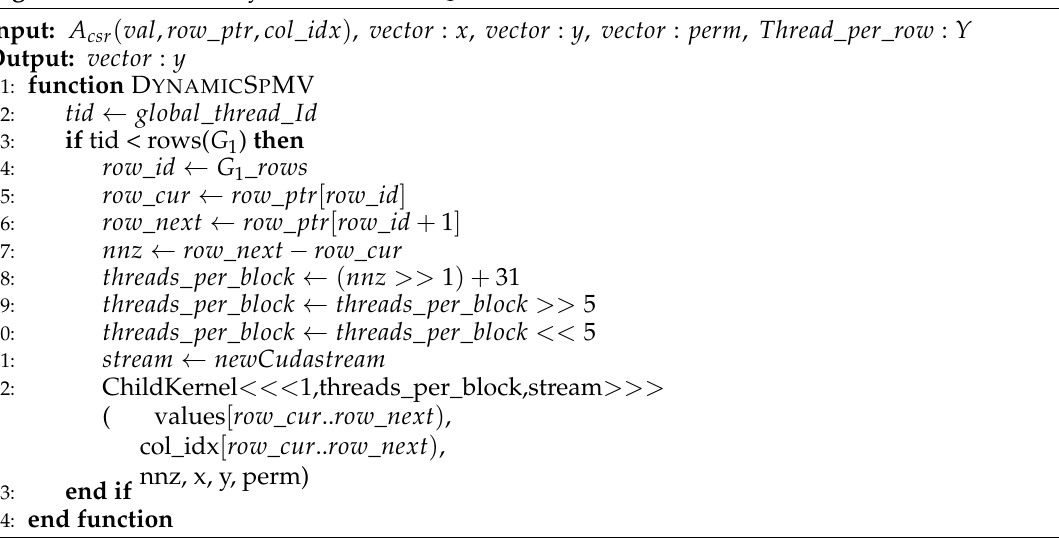
Algorithm 3 SURAA_Dynamic_Kernel_ G